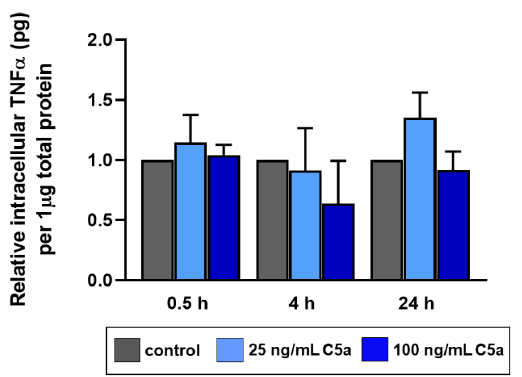
Figure 5. ELISA analysis of intracellular TNFα after 0.5 h, 4 h, and 24 h stimulation with 25 ng/mL (light blue) and 100 ng/mL (dark blue) recombinant C5a protein in comparison to the control group (grey). The values were measured in pg per 1 µg of cell lysate total protein. Mean values and the standard errors of mean are shown. Controls have been normalized to 1. Rout outlier test Q = 1.0%. Shapiro Wilk normality test was used to evaluate the normal distribution of data. One sample t -test was performed. n = 3 independent experiments with human tenocytes from different donors were performed.